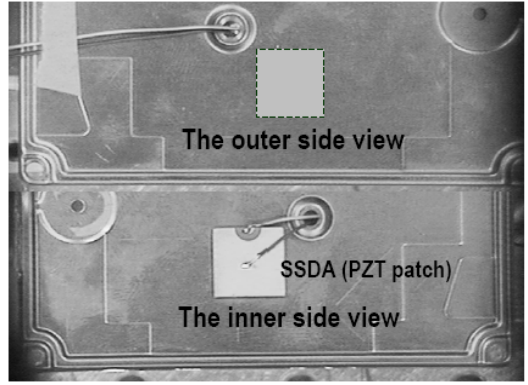
Figure 2. The Feedback Control of Disk Vibration/Flutter via DSSA